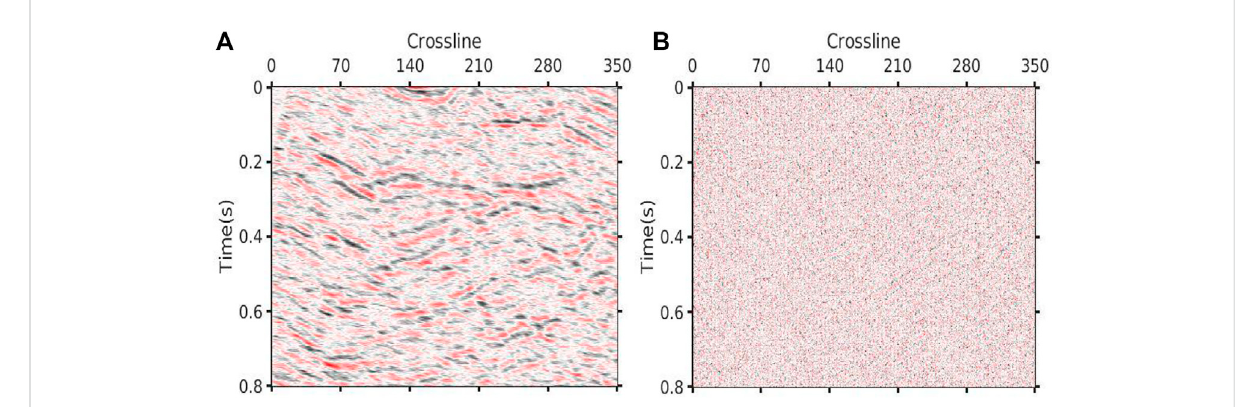
FIGURE 16 Denoising result via DCT+K-SVD. (A) Denoised data (SNR=3.67 dB PSNR=20.02 dB). (B) Removed noise.